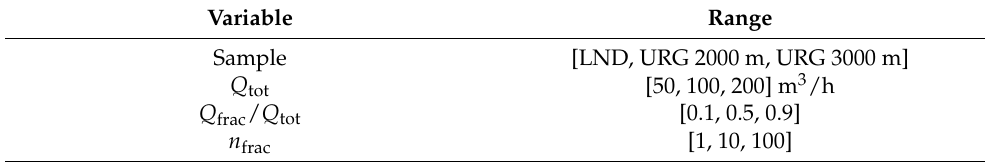
Table 2. The reservoir simulation variables and ranges that were considered for the exhaustive scenario analysis. Each unique parameter combination represents a scenario (3 4 = 81